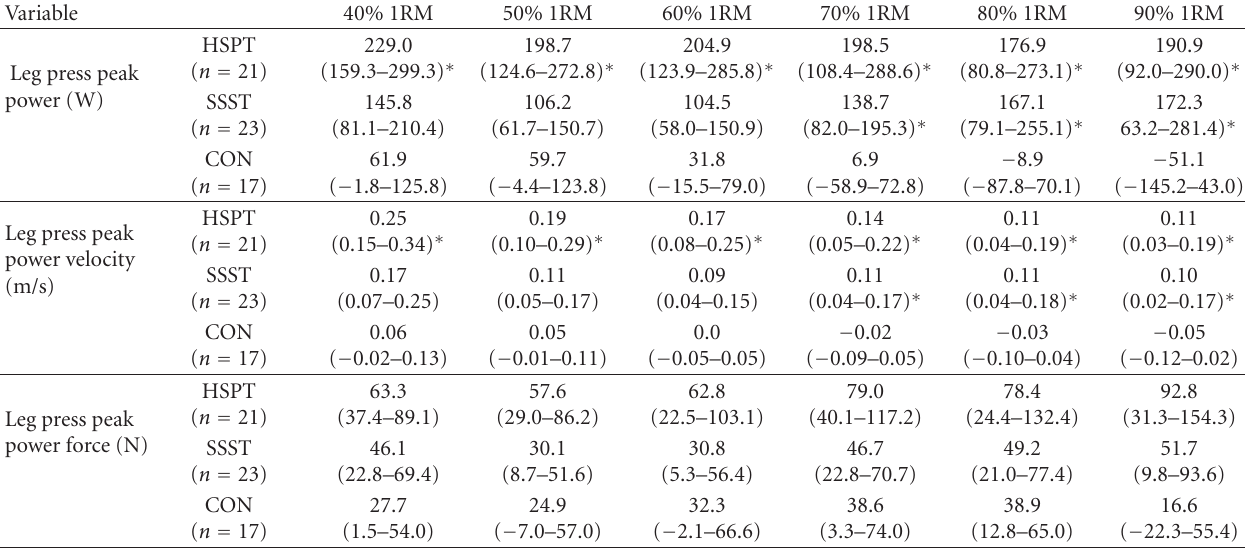
Table 2: Change in muscle performance across a range of external resistances after 12-weeks of training (using loads relative to baseline 1RM). Data represent mean (95%